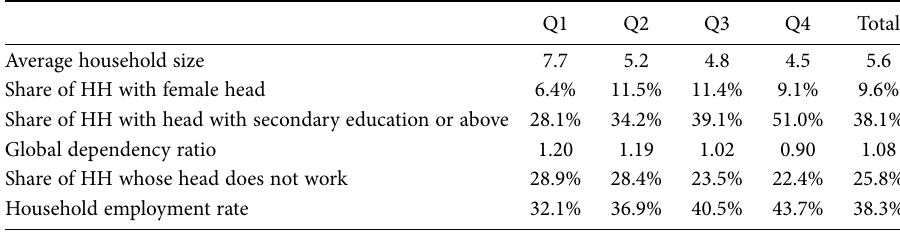
Table 5. Households’ profile per poverty quartile, 2013.